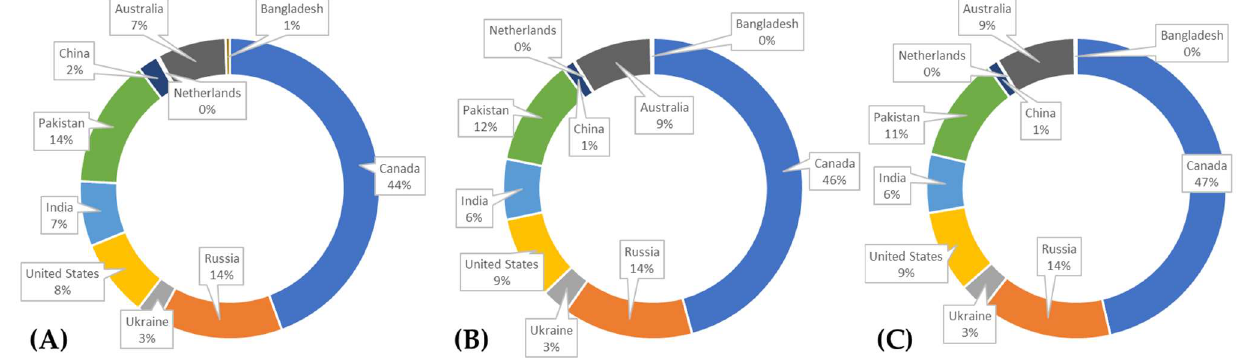
Figure 12. Top ten countries exporting crops to Sri Lanka during 2010–2020: ( A ) total quantities, ( B ) virtual water, ( C ) virtual land for top ten